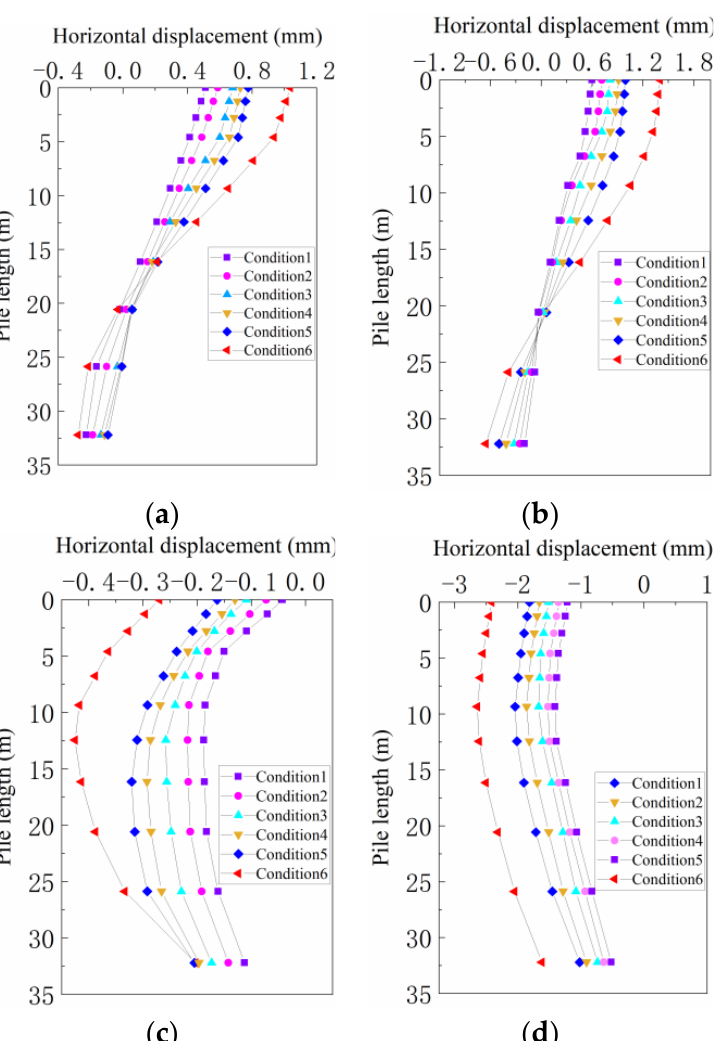
Figure 13. Distribution of horizontal displacement of the bridge pile along the long side of the foundation excavation. ( a ) Point A; ( b ) Point B; ( c ) Point C; ( d ) Point D. By comparing working condition 5 (excavating to the bottom without the train load) with working condition 6 (applying the train load when excavating to the bottom) of each pile foundation, the horizontal displacement of the pile foundation along the long side of the foundation excavation was aggravated by the train load. The dynamic load had a great influence on pile displacement, and the maximum deformation occurred at the top of piles. The maximum displacements of piles A and B were 1.03 and 1.4 mm, respectively, and the increasement percentages were 34% and 41%, respectively when considering the train load during excavation. Therefore, the amplification effect of the train dynamic load on the pile deformation is evident. The deformation of piles C and D also increased under dynamic load, and the maximum displacements were 0.43 and 2.64 mm, respectively. The increasement percentages were approximately 34% and 30%, respectively compared to the working condition 5 without train